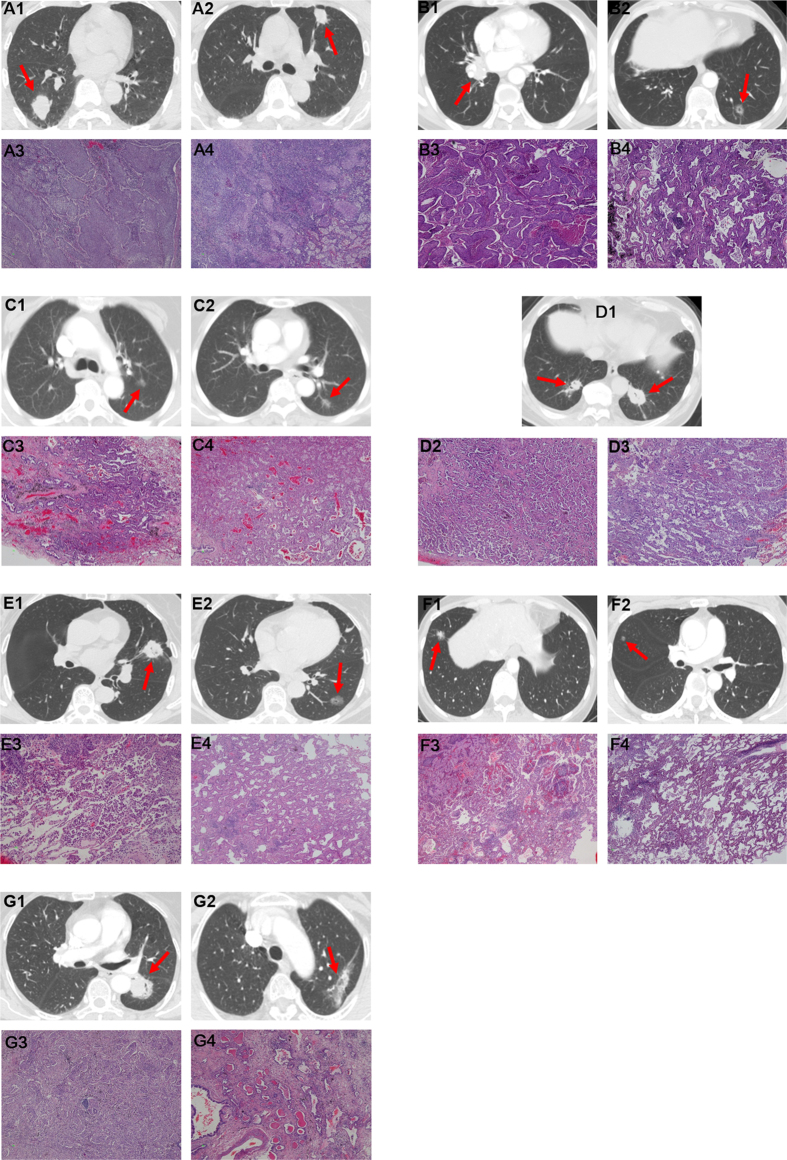
Synchronous multiple primary lung cancers were detected on computed tomography (CT) and confirmed by pathological diagnoses (Hematoxylin-eosin staining, 40×).(A) Squamous cell carcinoma in the right lower lobe (A1,A3) and left upper lobe (A2,A4) of the lung. (B) Squamous cell carcinoma in the right lower lobe (B1,B3) and adenocarcinoma in the left lower lobe (B2,B4) of the lung. (C) Both of acinar predominant adenocarcinoma in the left upper lobe (C1,C3) and lower lobe (C2,C4) of the lung. (D) Acinar predominant adenocarcinoma in the left lower lobe (D1,D3) and lepidic predominant adenocarcinoma in the right lower lobe (D1,D2) of the lung. (E) Micropapillary predominant adenocarcinoma in the left upper lobe (E1,E3) and lepidic predominant adenocarcinoma in the left lower lobe (E2,E4) of the lung. (F) Papillary predominant adenocarcinoma in the right lower lobe (F1,F3) and lepidic predominant adenocarcinoma in the right middle lobe (F2,F4) of the lung. (G) Solid predominant adenocarcinoma in the upper lower lobe (G1,G3) and acinar predominant adenocarcinoma in the left upper lobe (G2,G4) of the lung.